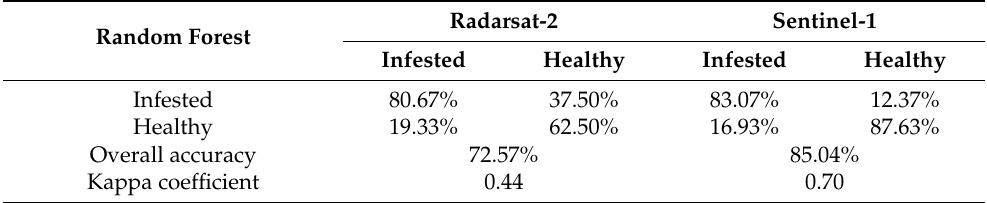
Table 4. Confusion matrices and accuracy indices of random forest algorithms corresponding to Radarsat-2 and Sentinel-1 data.